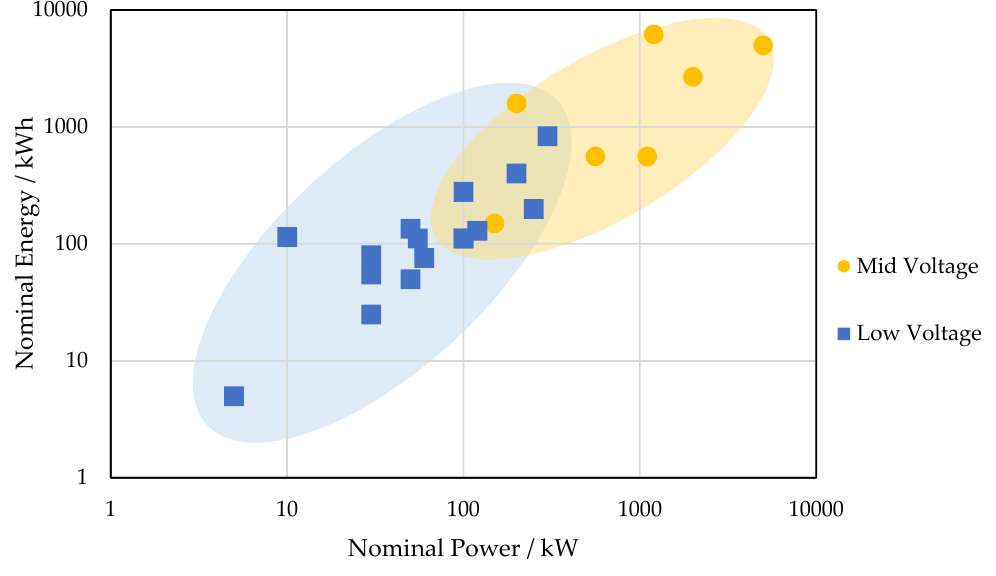
Figure 4. Grid level study of selected Battery Energy Storage System (BESS) in Germany showing the alignment of storage system power/energy with the voltage level of system grid connection. Data from